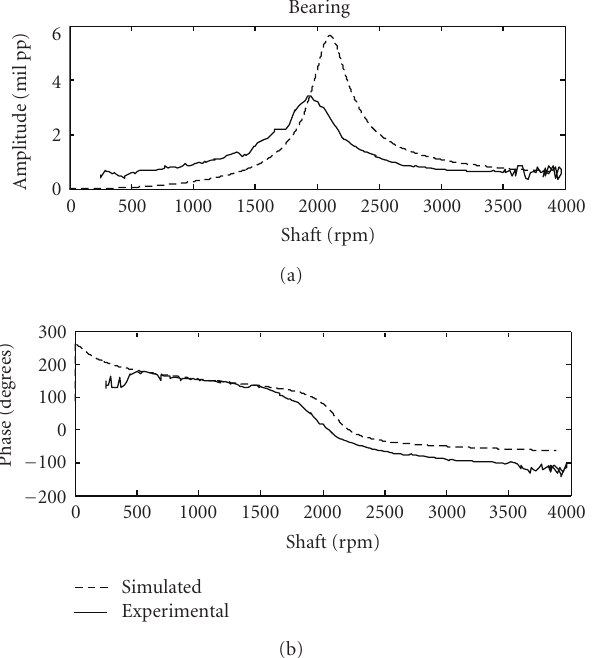
Figure 16: Synchronous response of a bowed rotor at midplane disk. Ro = 1.09, ao = 180 ◦ .